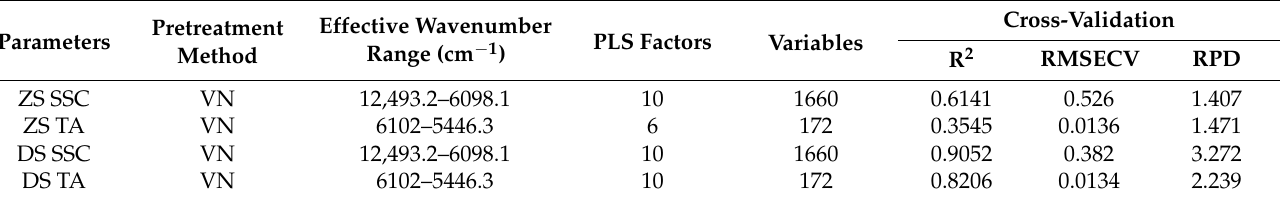
Table 2. Performance parameters of a pear variety calibration model with optimized data preprocess- ing methods.